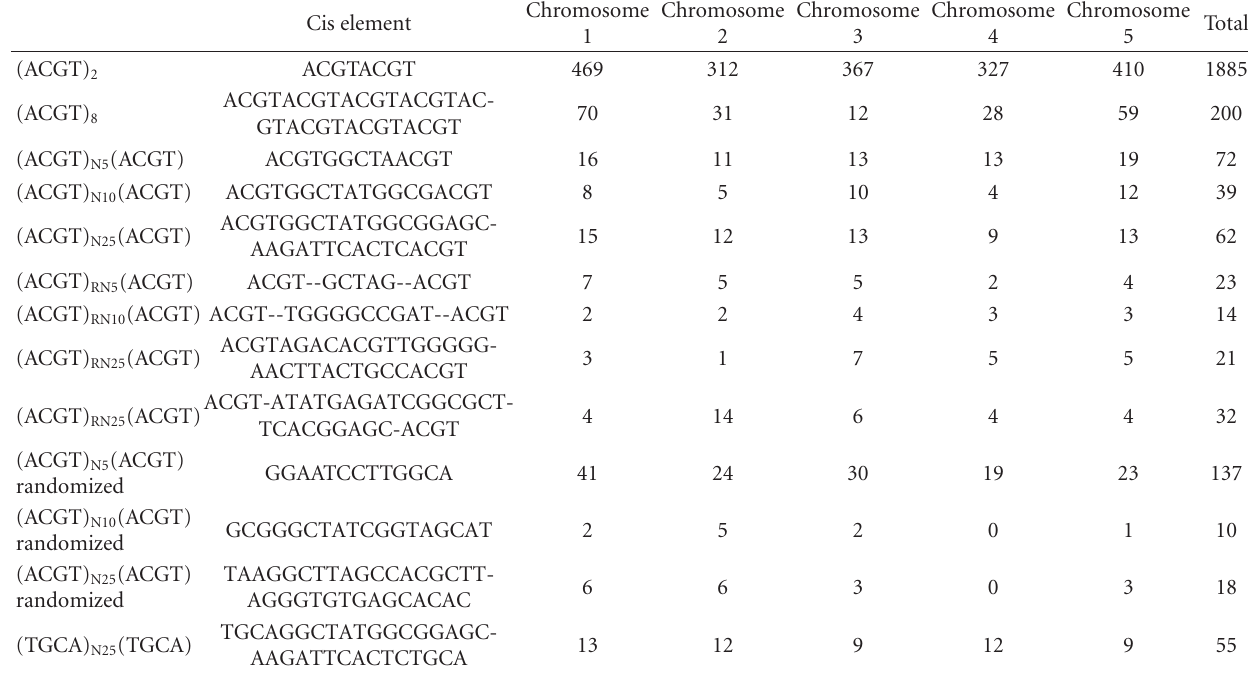
Table 1: Frequency of occurrence of the various promoter sequences in which spacer sequence length between two ACGT palindromes is gradually increased from 5 to 25